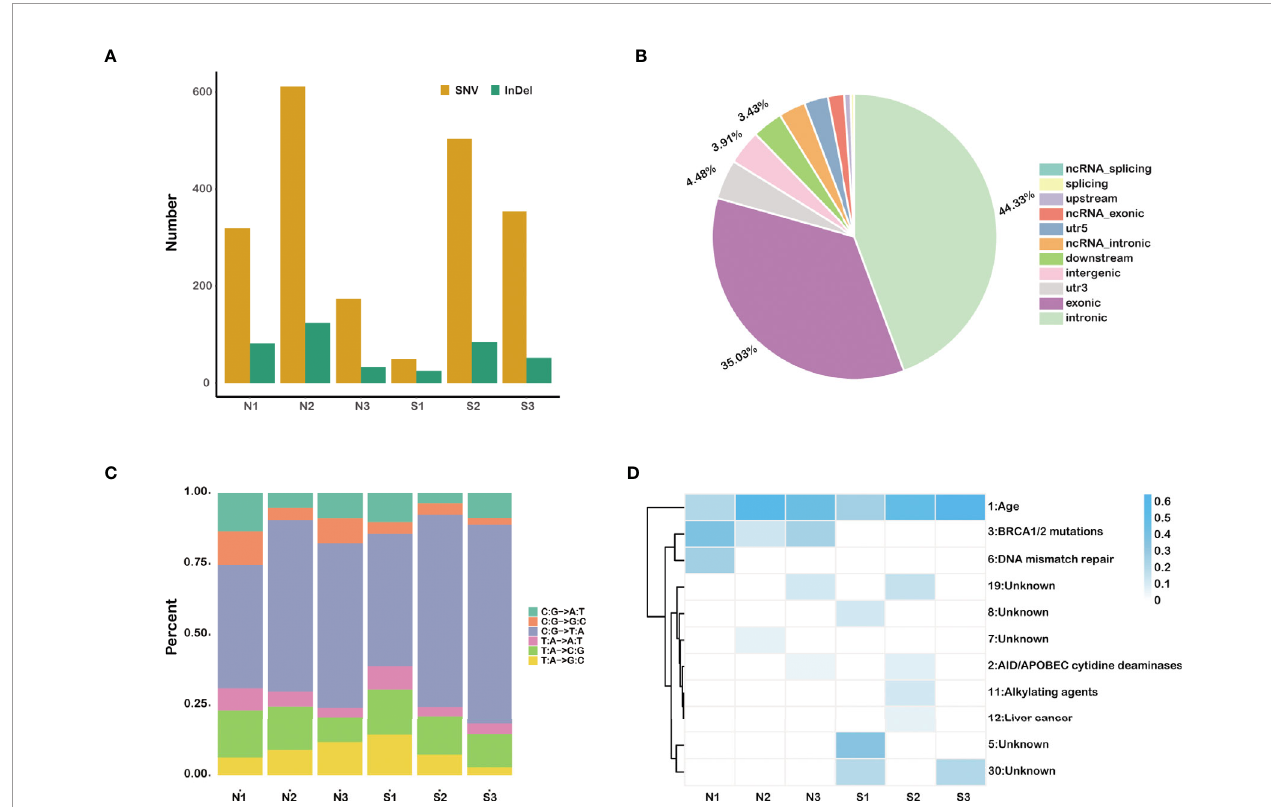
FIGURE 1 | The somatic mutation pro fi les of six primary pancreatic tumor samples. (A) Total number of SNVs and InDels detected in each sample. (B) The statistics of somatic mutations in the genome. (C) The distribution of mutation type for each sample. (D) The mutation signature distribution based on COSMIC signature